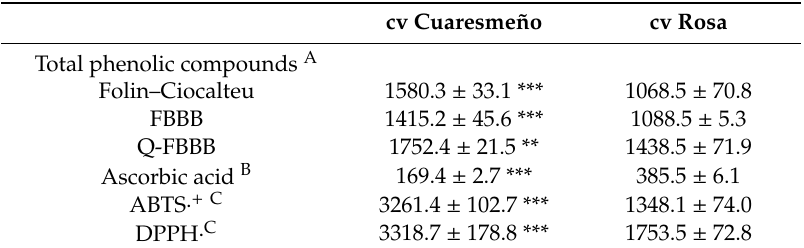
Table 2. Antioxidant properties of two cultivars of